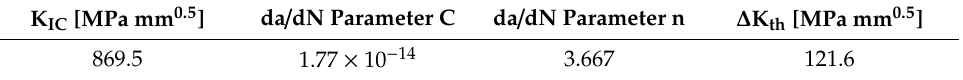
Table 4. Crack propagation (Paris law) for the Ti-6Al-4Va used in this paper (data adapted from [1]).